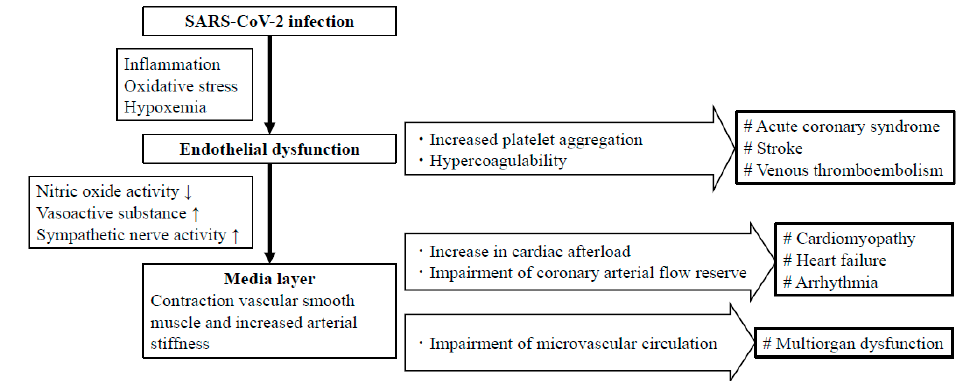
Figure 2. Mechanisms of cardiovascular dysfunction in acute phase of COVID-19.